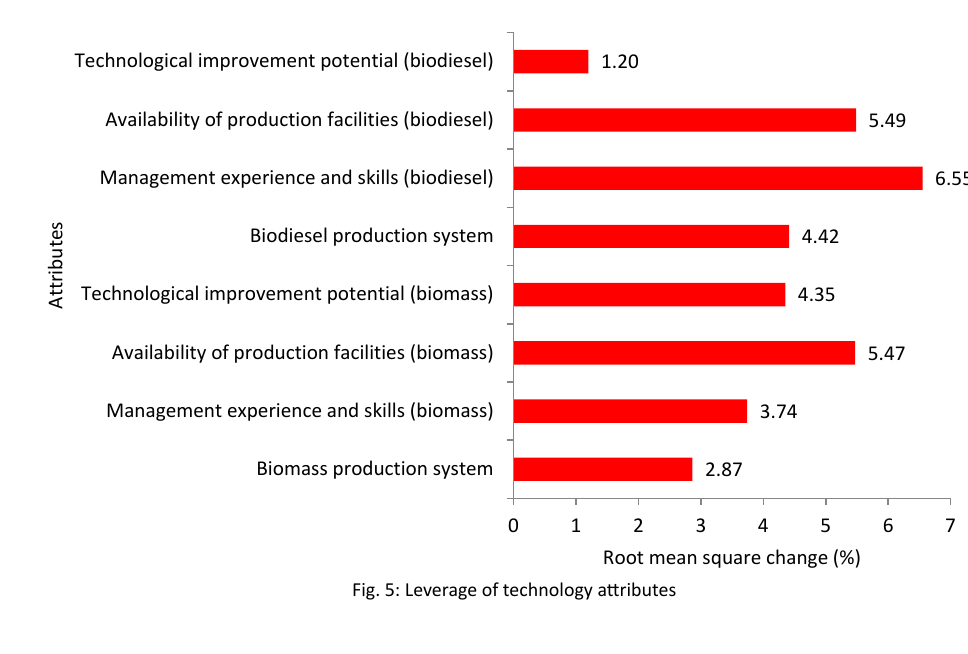
Fig. 4: Leverage of economic attributes